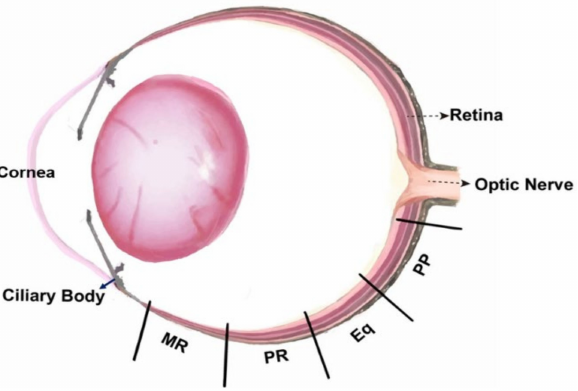
Figure A2. Diagram showing four locations from which confocal images were taken. PP, posterior pole; Eq: equator; PR: peripheral retina; MR: marginal